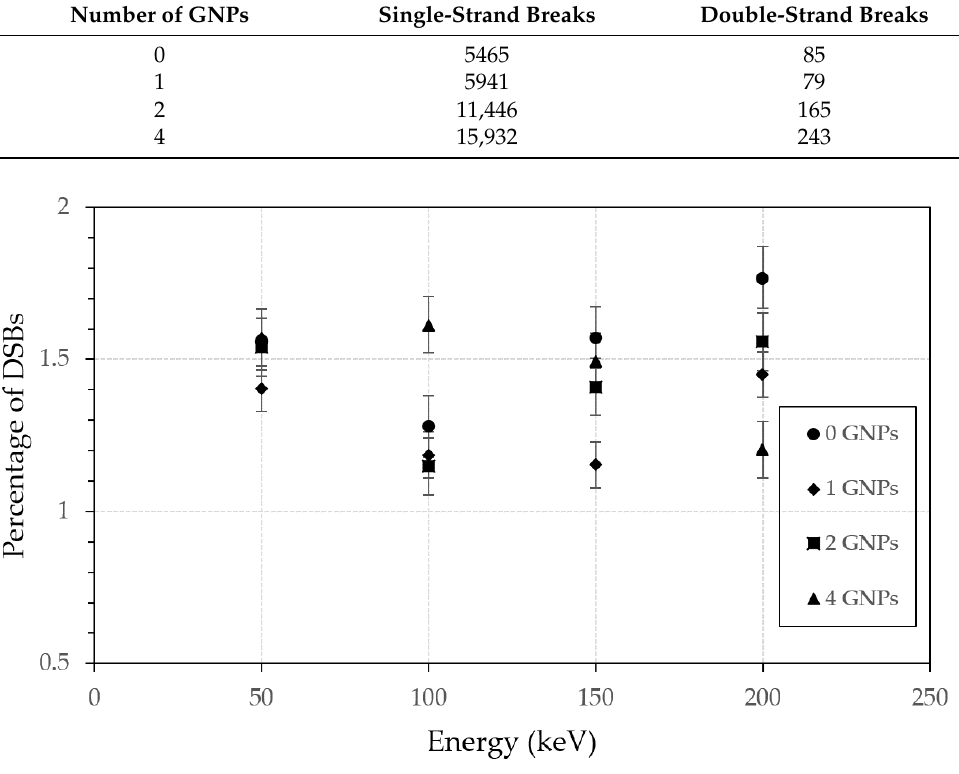
Figure 5. Plot of the percentage of DSBs present at different energies when 0, 1, 2, and 4 GNPs are present. Table 1. Comparison of the number of SSBs to DSBs with increasing number of gold nanoparticles for all energies of 50, 100, 150, and 200 keV combined.